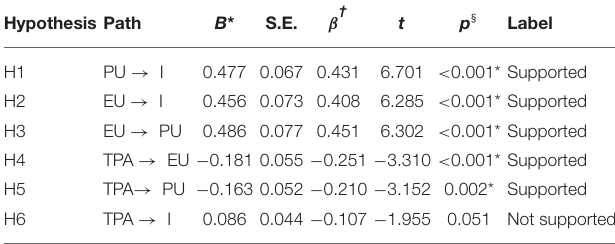
† Standardized regression weight. t-test value. § p-value is significant at